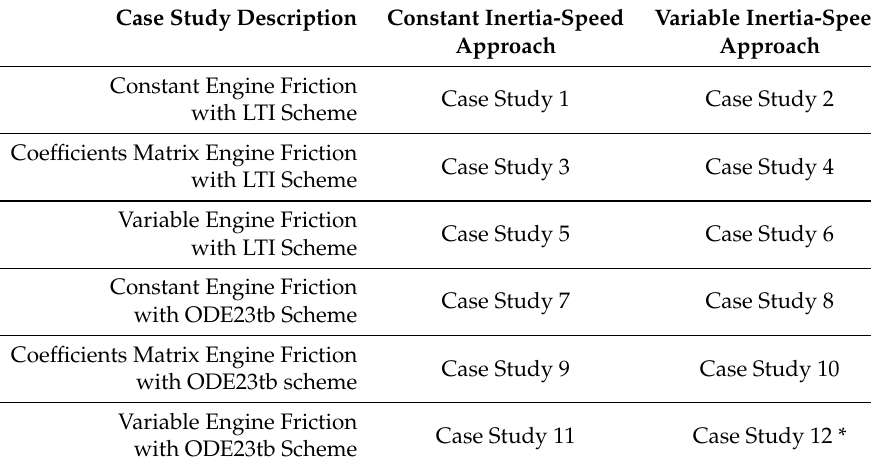
Table 2. List of case